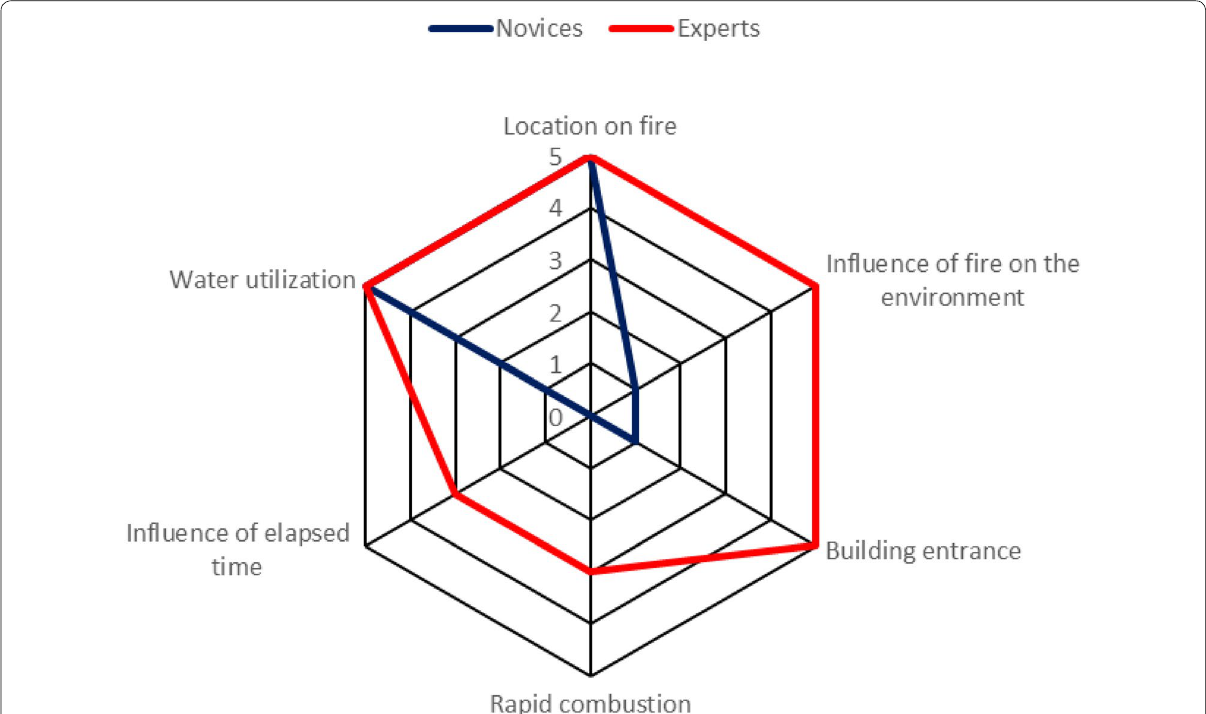
Fig. 12 Comparison of checklist items evaluated by novices and experts during